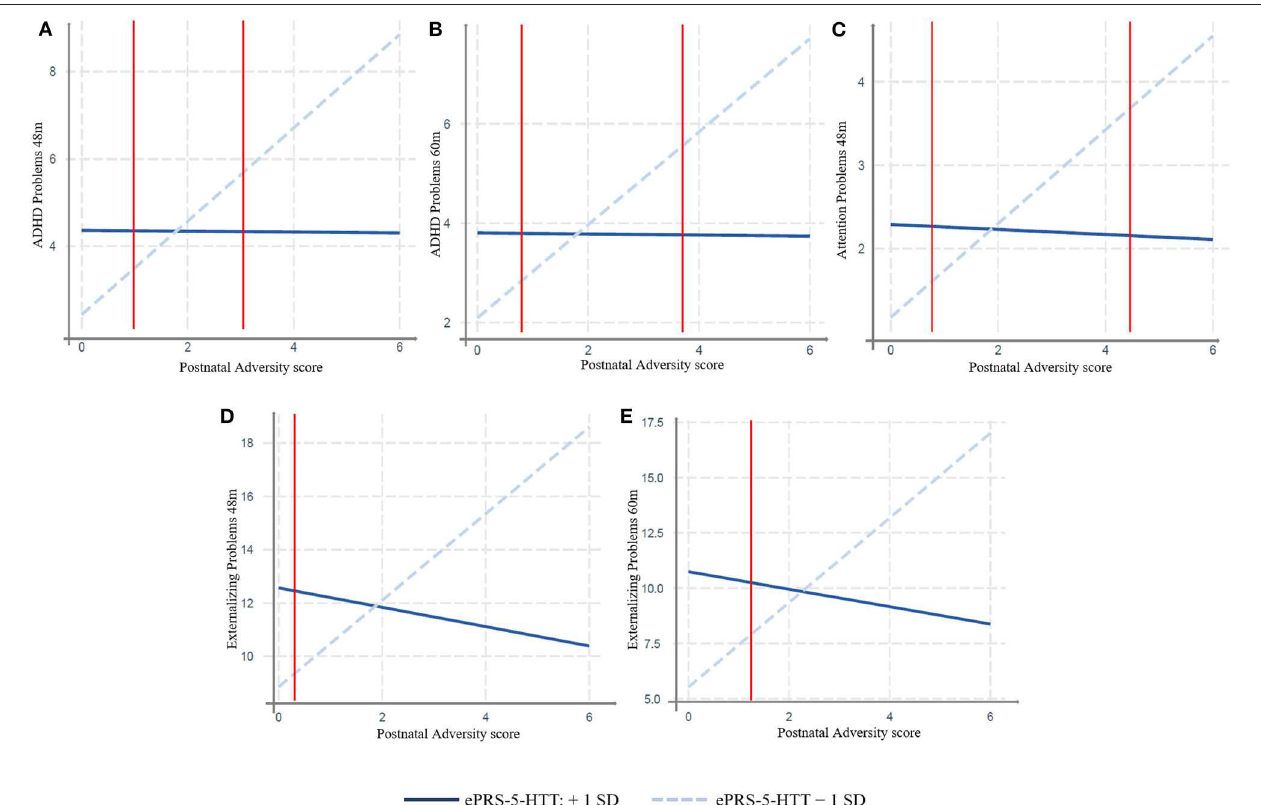
FIGURE 2 | Interaction between Postnatal Adversity Score and amygdala-based ePRS-5-HTT on: (A) ADHD problems 48 and (B) 60 months ( N = 137), (C) Attention Problems at 48 months (D) Externalizing Problem at 48 months (E) and 60 months. Increased postnatal adversity exposure is associated with more problematic behavior outcomes as the ePRS decreases. MAVAN cohort, N =